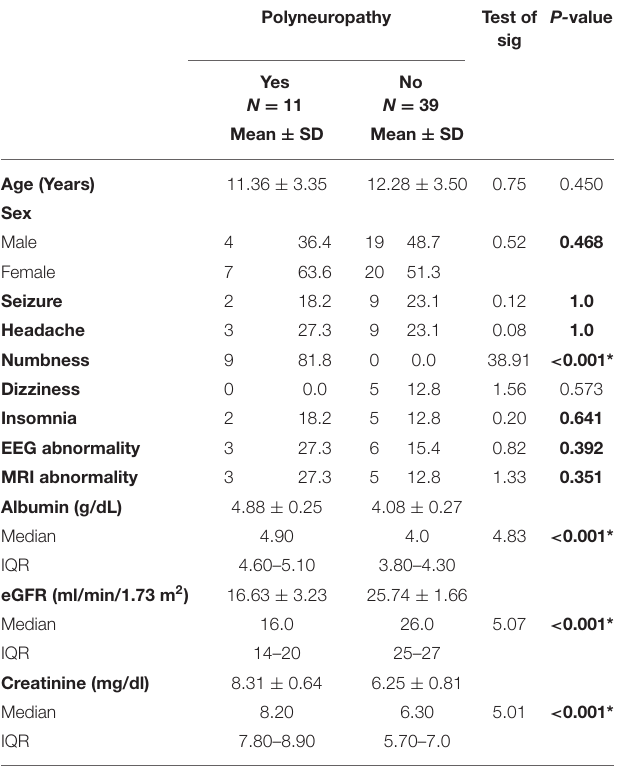
TABLE 4 | Distribution of demographic, clinical, and neurological examination in patients with CKD with and without peripheral neuropathy. Polyneuropathy Test of sig